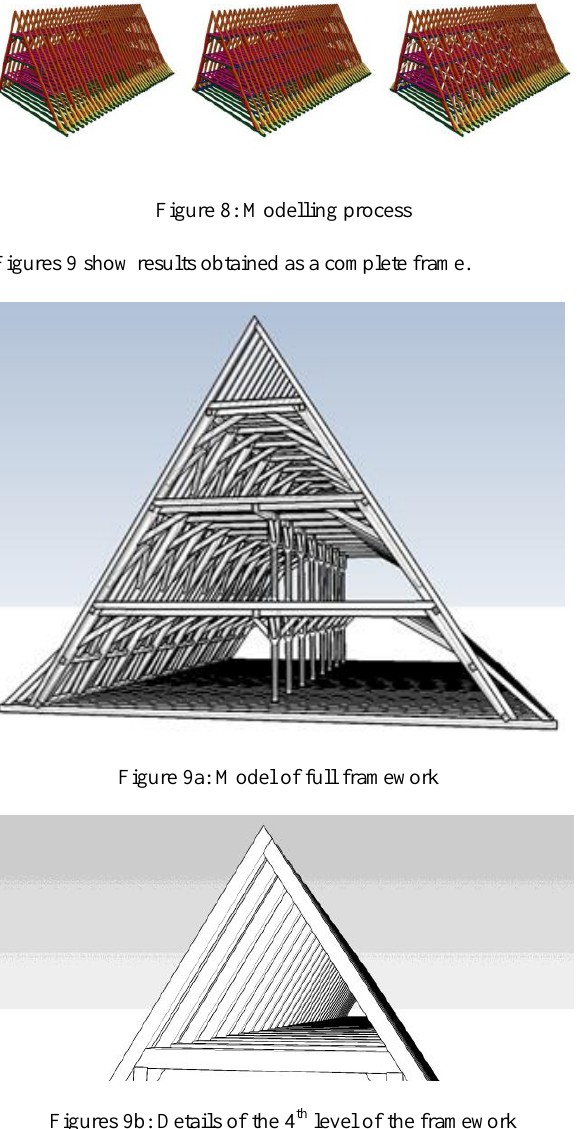
Figures 9b: Details of the 4 th level of the framework